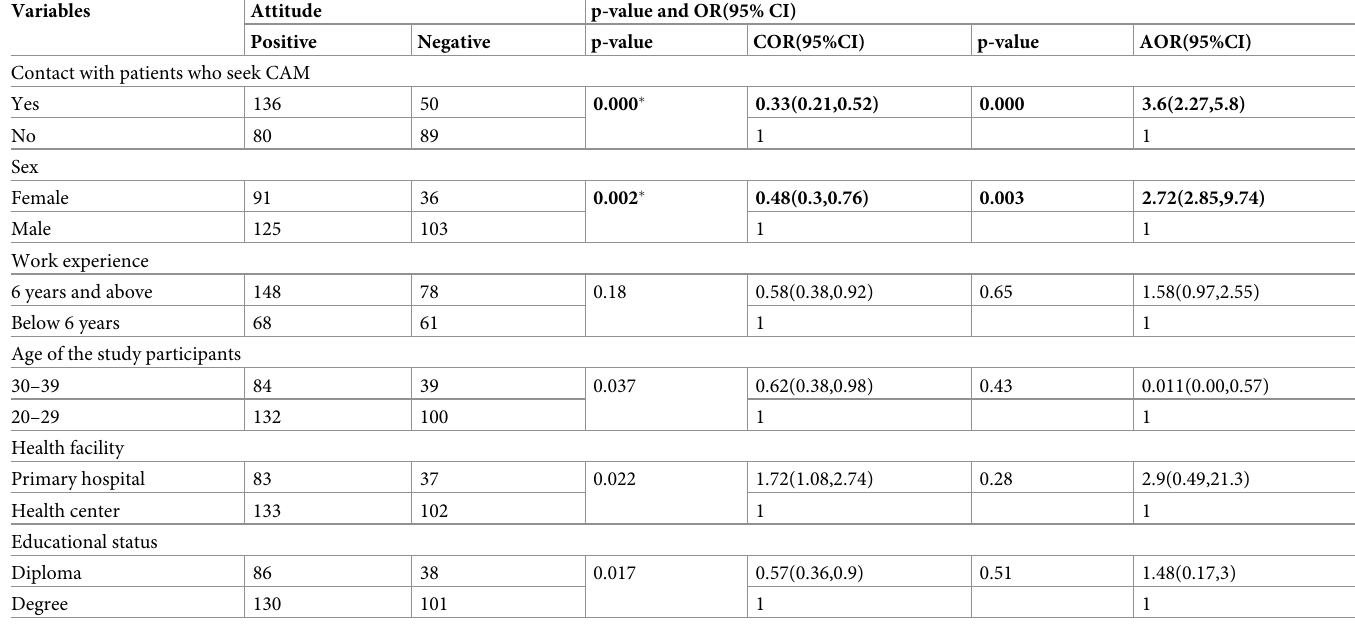
Table 4. Bivariate and multivariable analysis of factors associated with attitude towards complementary and alternative medicine among health care professionals in selected primary health care unit in Hadiya Zone, Southern Ethiopia, April, 2021 (n = 355). Variables